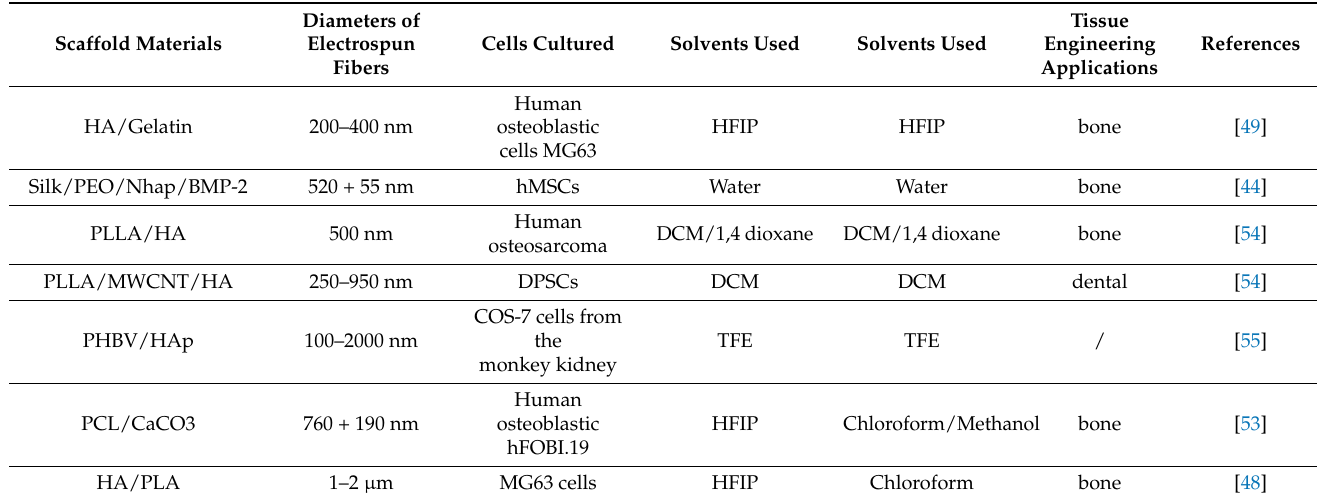
Table 2. Organic-inorganic nanocomposite